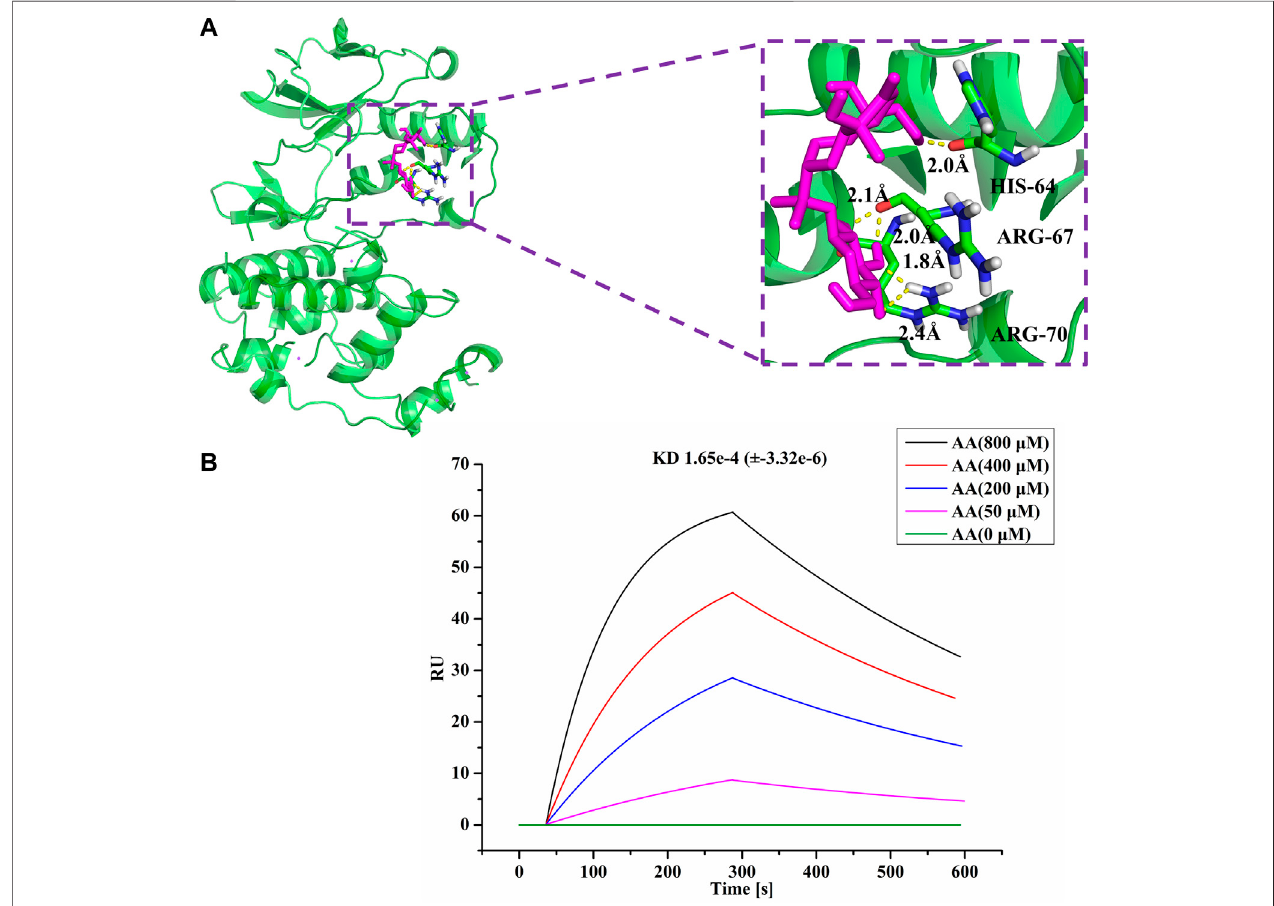
FIGURE7| AAdirectlyinteractedwithp38. (A) Moleculesarerepresentedbyaball-and-stickmodel,thehydrogenbondsarerepresentedbyadottedline,andthe distance is in angstroms. Atoms O and H of P38 are red and gray, respectively. (B) SPR analysis of the interaction between AA and p38.